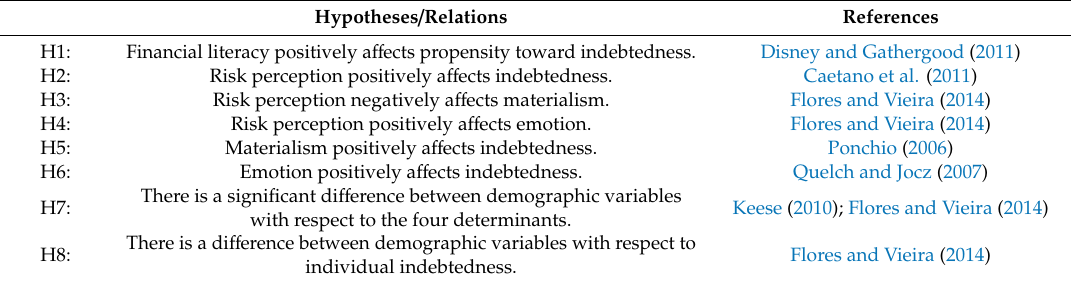
Table 1. Hypotheses and research relations with